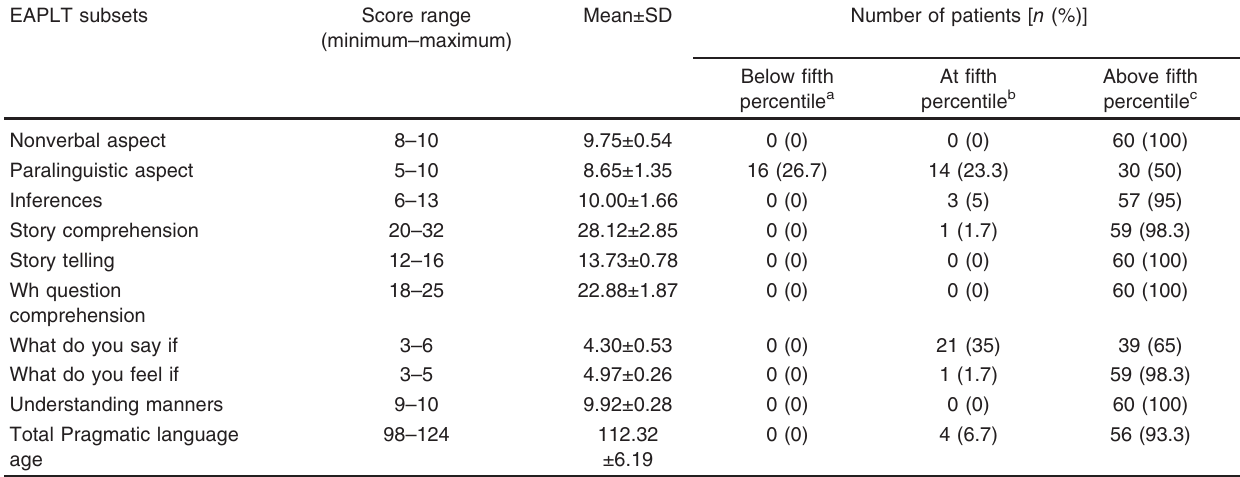
Table 7 Scores of the standardized Egyptian Arabic Pragmatic Language Test and the percentile ranks among the studied age groups EAPLT subsets